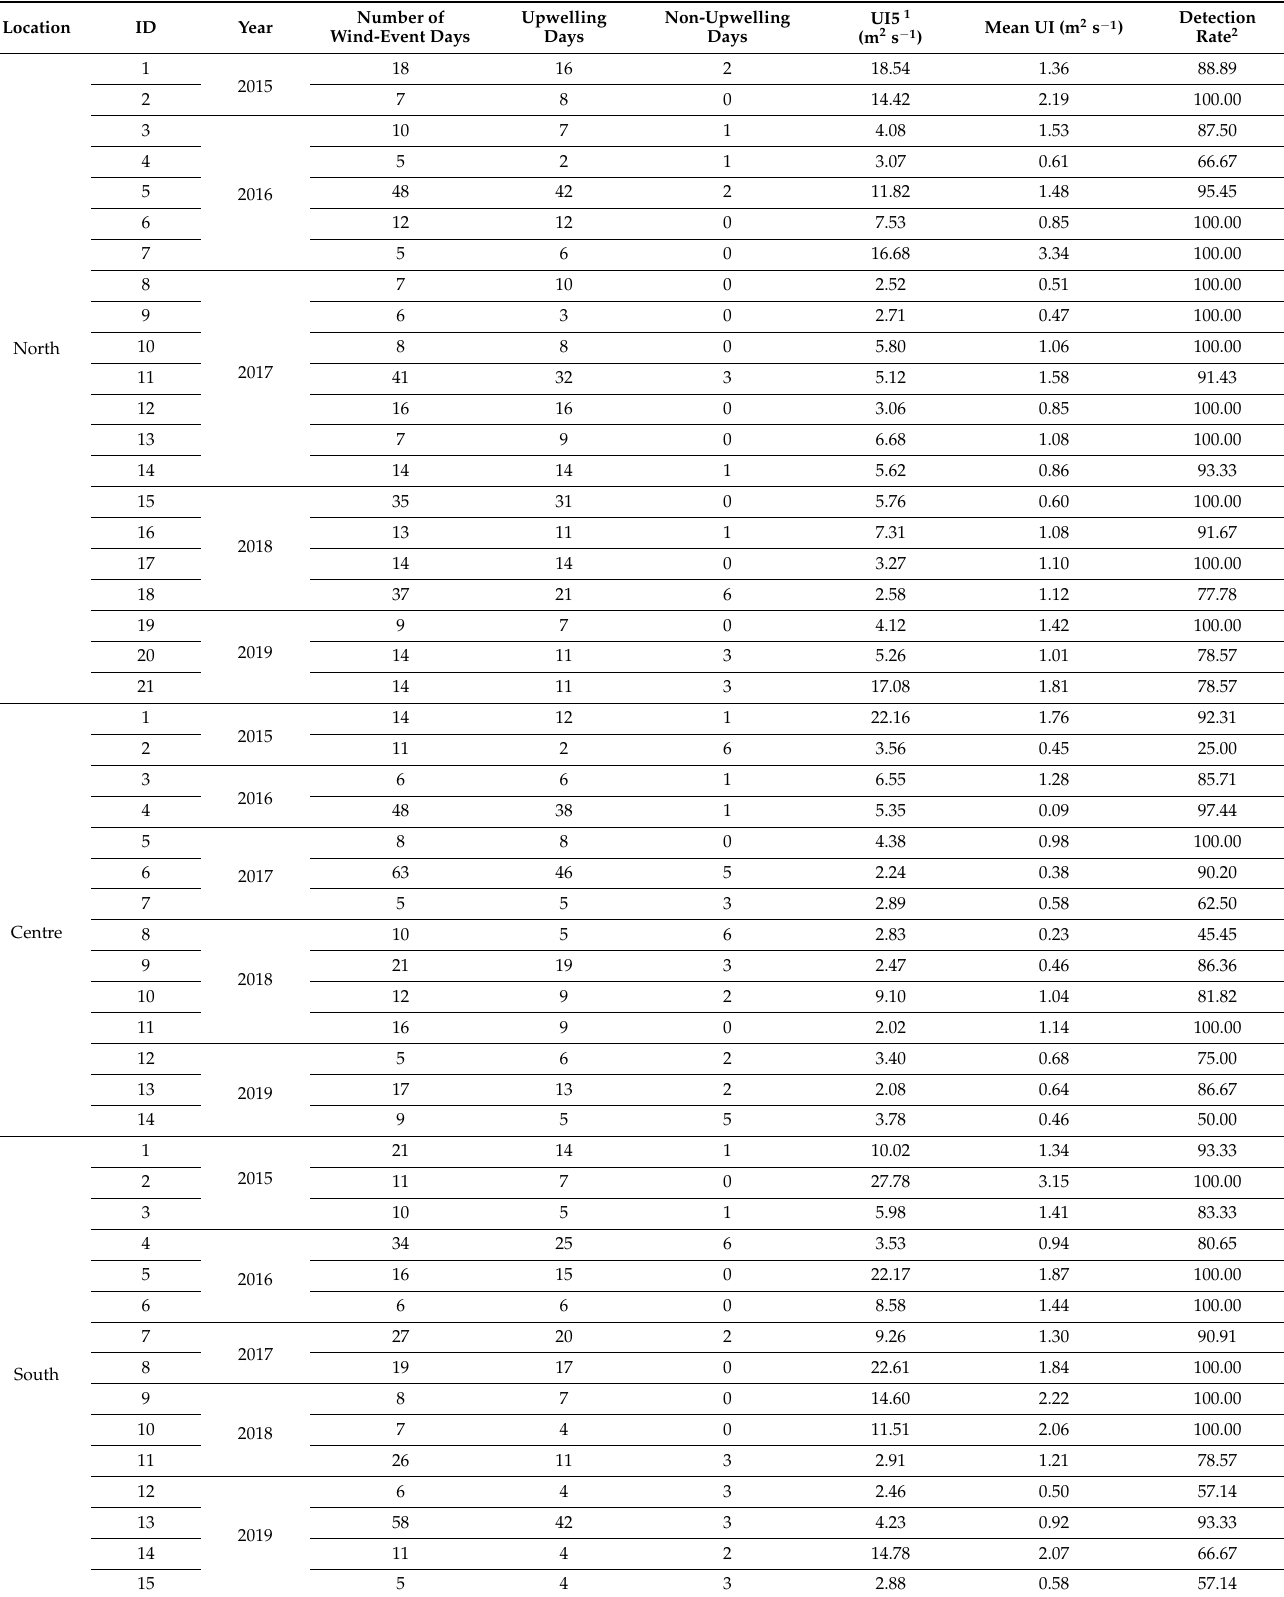
Table 1. The statistics of individual significant upwelling-favorable wind events and upwelling mapped from the H-8 SST data.